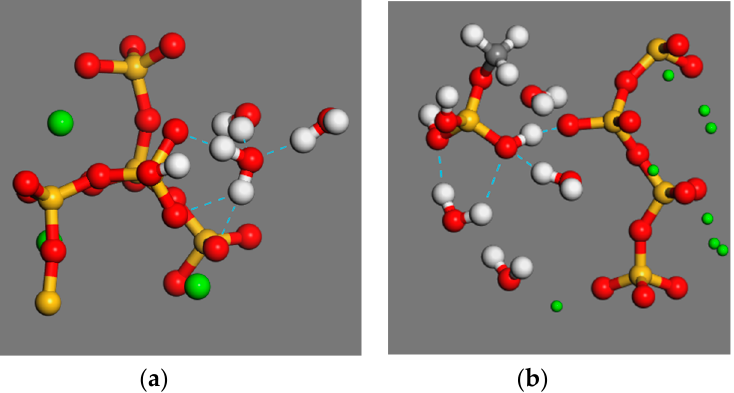
Figure 5. Displacement color map of ( a ) a pure aqueous solution, ( b ) 0.3 mol/L emulsion, ( c ) 0.6 mol/L emulsion, and ( d ) 0.9 mol/L emulsion. (The unit in the Y and Z directions is Å).